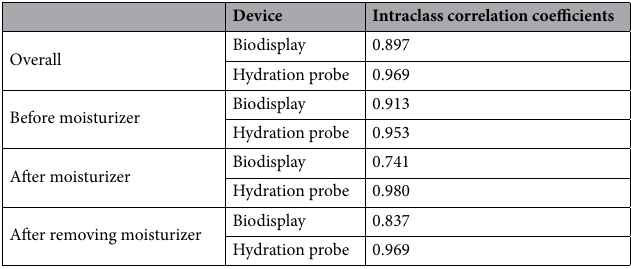
Table 3. Test–retest reliabilities of the Biodisplay and hydration probe.